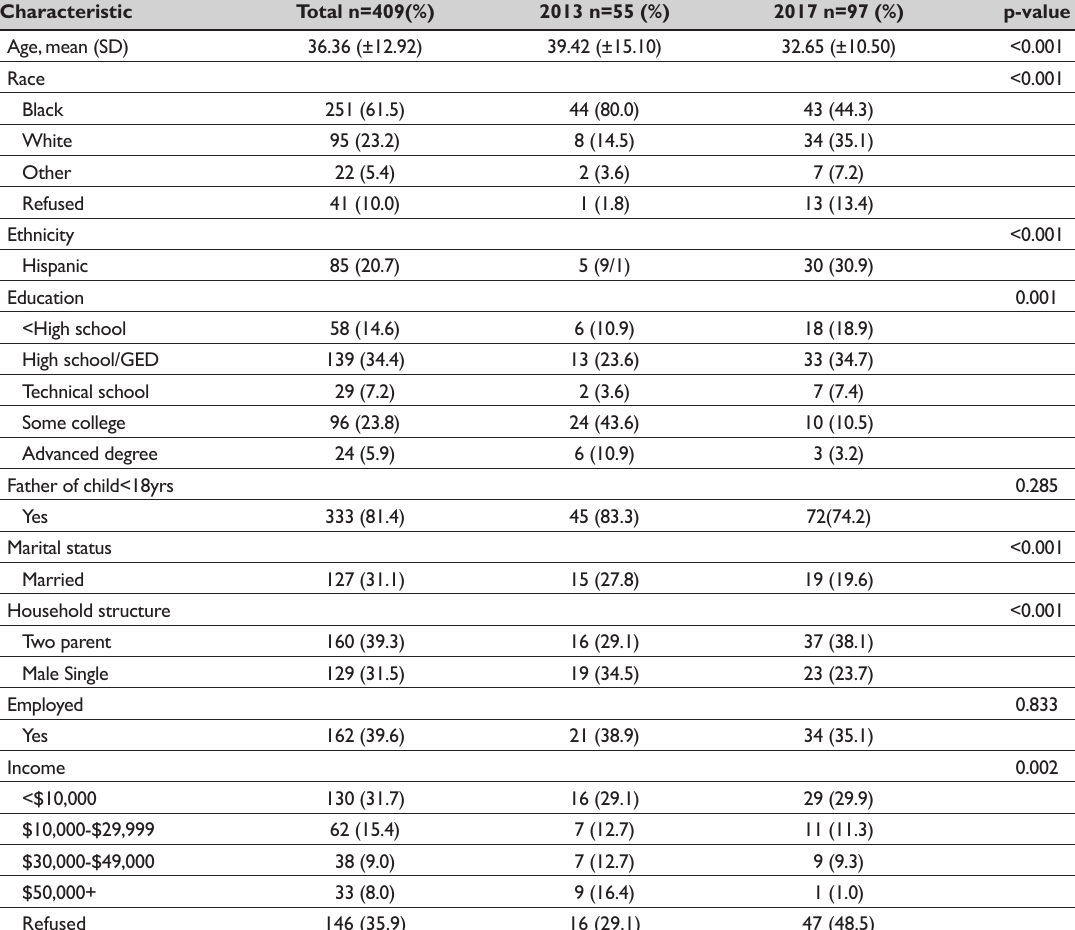
Table 1: Socio-demographic characteristics of fatherhood training participants, reachup, inc. ,